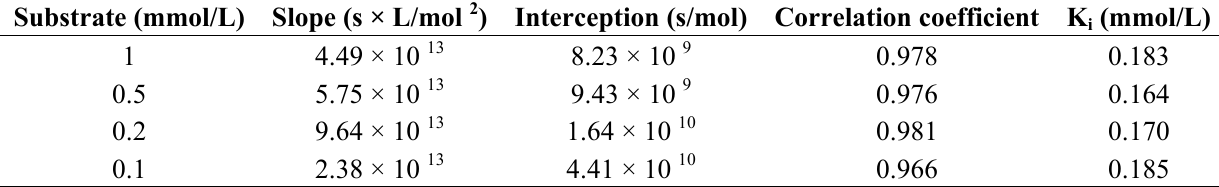
Table 1. Search on inhibitory mechanism using human AChE.